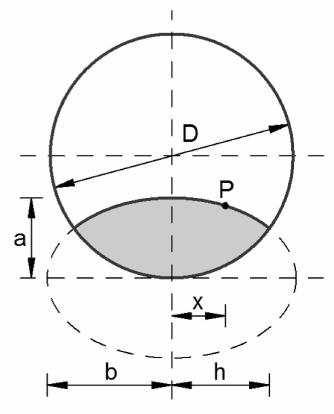
Figure 2. Elliptical crack